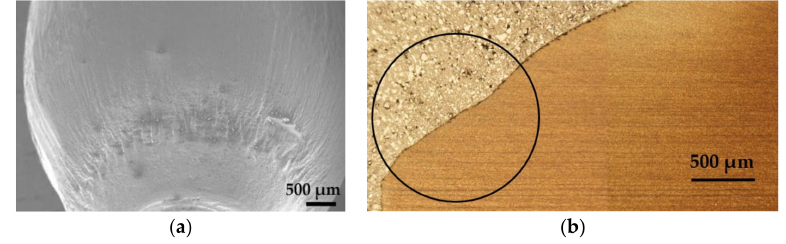
Figure 4. The active punch surface after 7000 strokes: ( a ) SEM analyse; ( b )